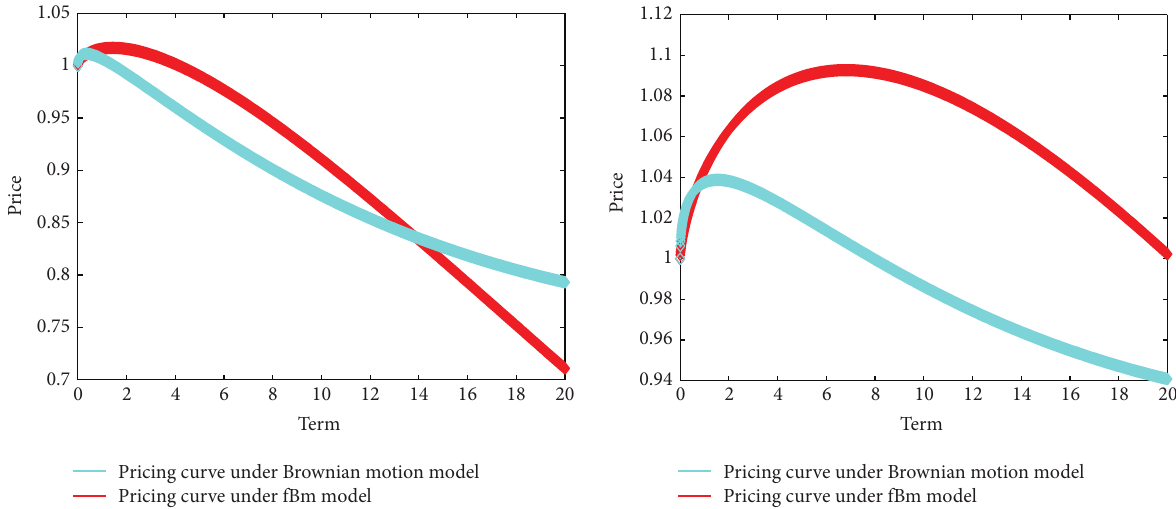
Figure 2: Comparison pricing 𝑃 𝛼 as a function of 𝑇 given 𝜎 = 20 %, 𝑟 = 5 %, 𝛿 = 2 %, and 𝐾 = 0.9𝑒 0.03𝑇 , for 𝛼 = 0.6, 0.9 , respectively.